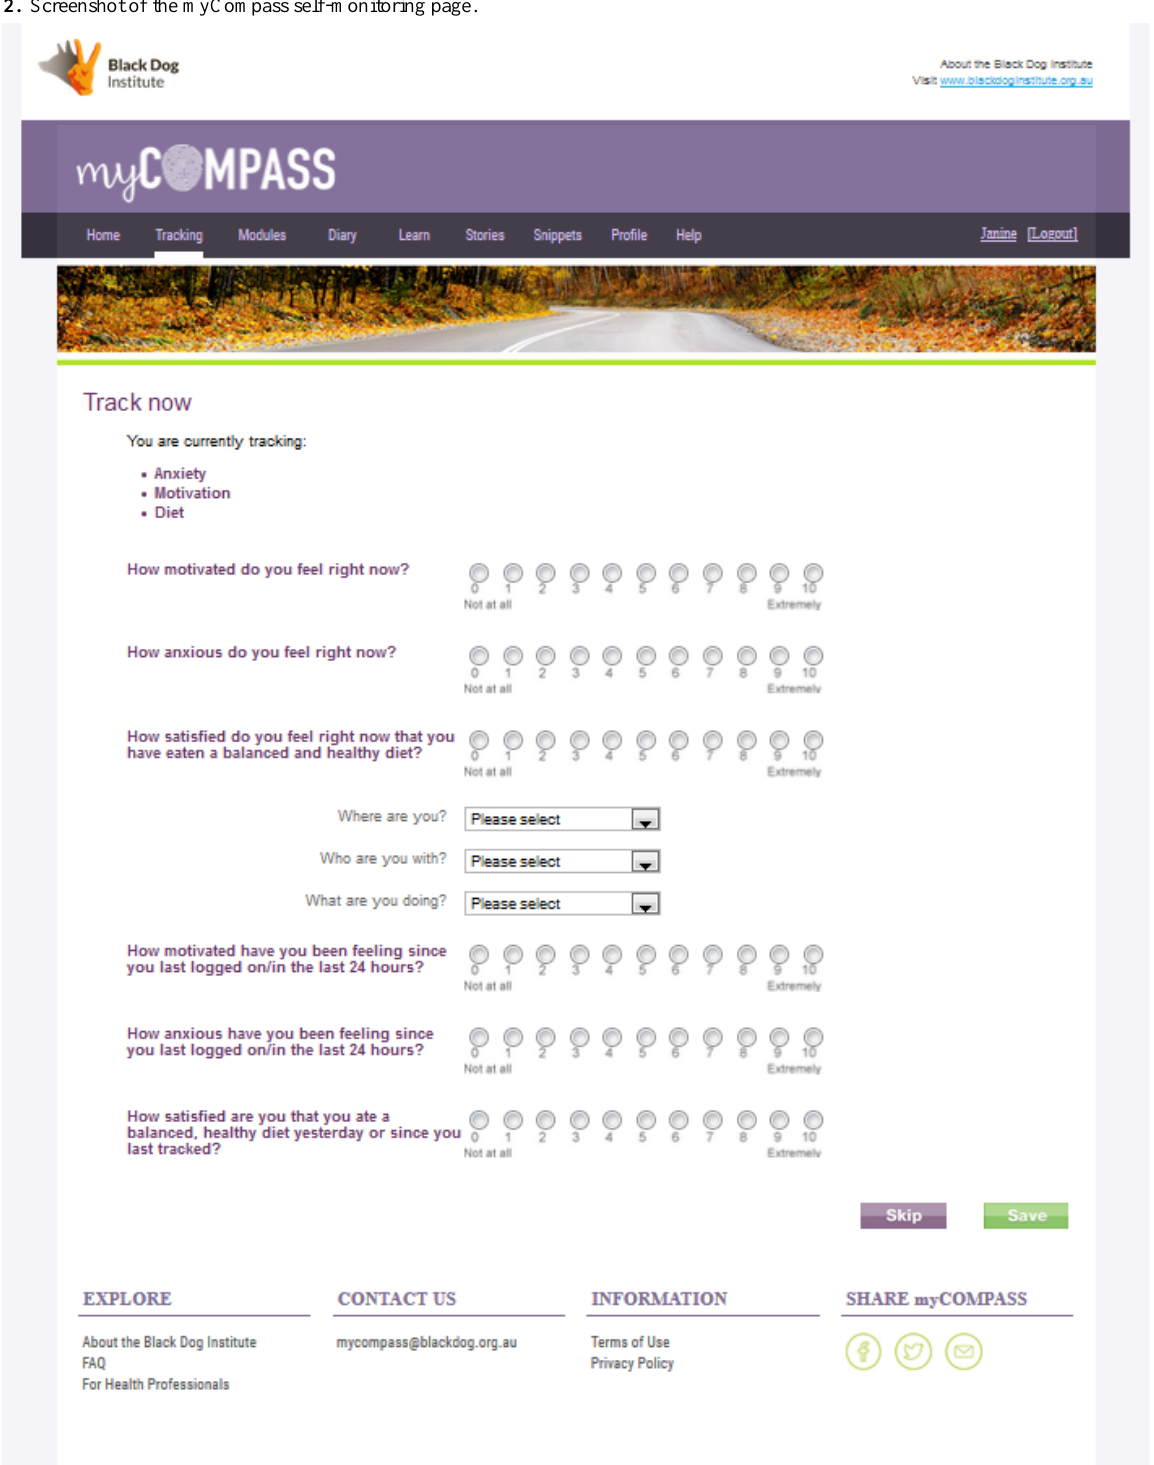
Figure 2. Screenshot of the myCompass self-monitoring